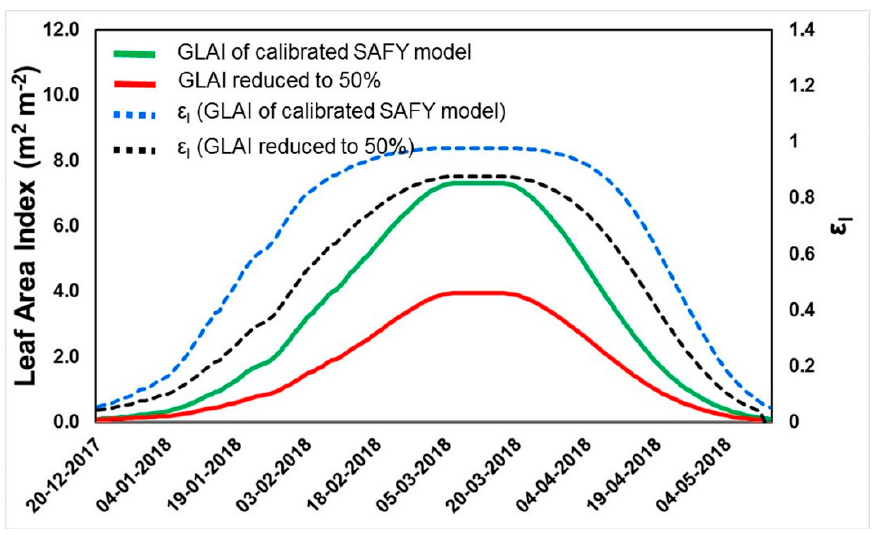
Figure 11. Light-interception efficiency ( ε I ) response curve to change in the green leaf area index (GLAI) for normal (green line) and a 50% reduction in LAI (red line) based on Equation (2).